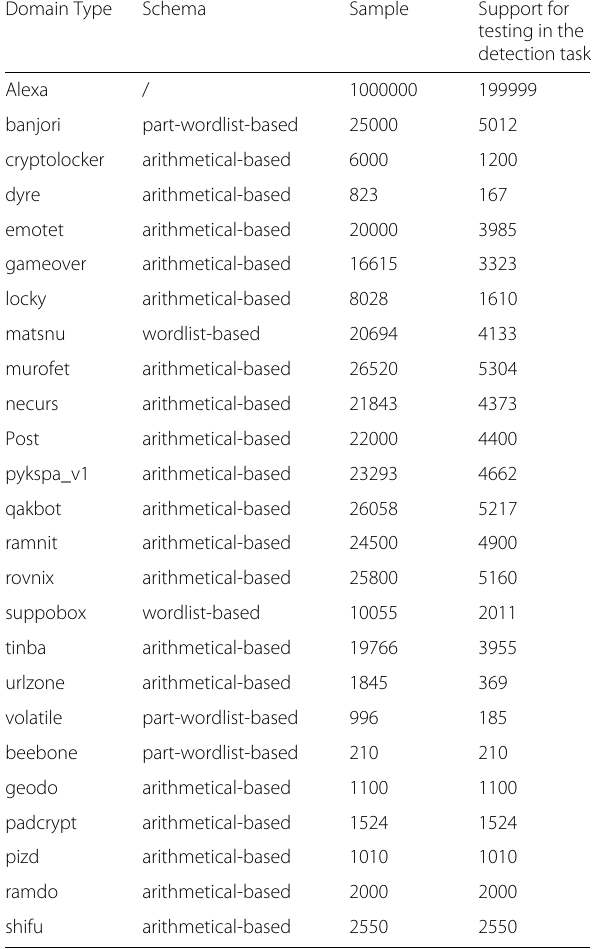
Table 1 Summary of the collected